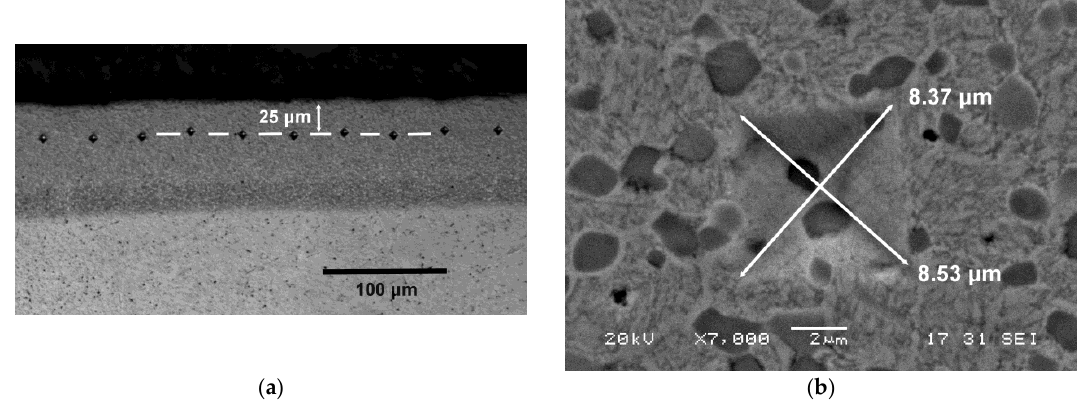
Figure 1. A total of 20 indentations were made for each experiment. ( a ) All the indentations were placed at 25 μm from the outer edge of the nitrided layer; ( b ) The measurements were determined at 7000× on a scanning electron microscope (SEM) images.